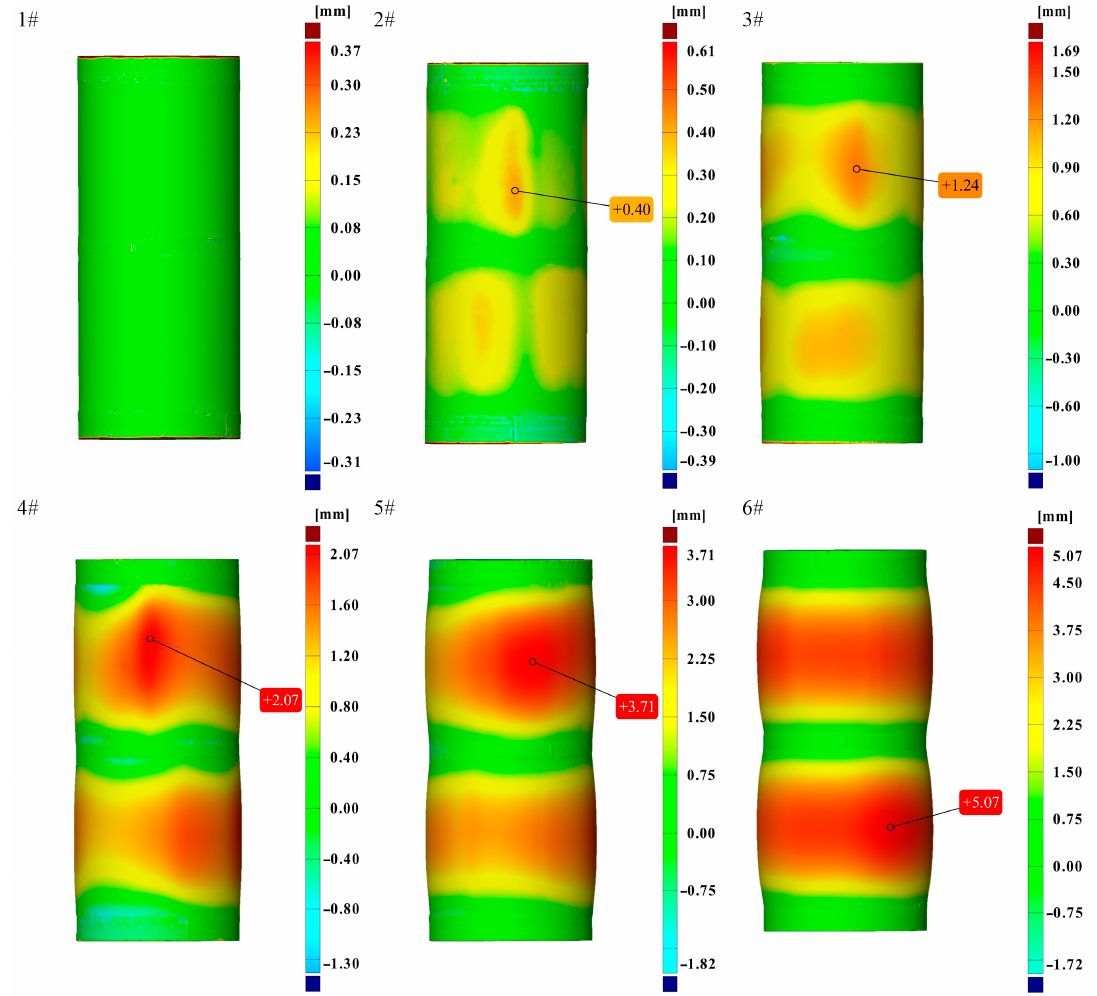
Figure 5. Shape deviations from the perfect geometry for bi-segment bulged hulls.